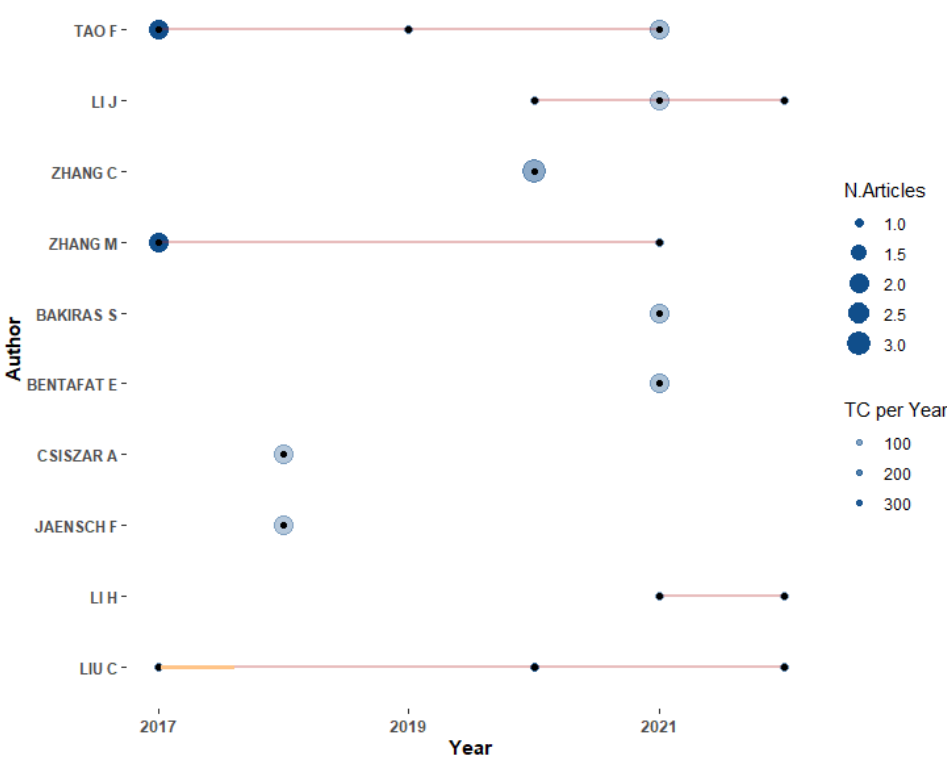
Figure 6. Top authors with citation. A chart with circle size representing number of articles and circle colour representing citation rate for top